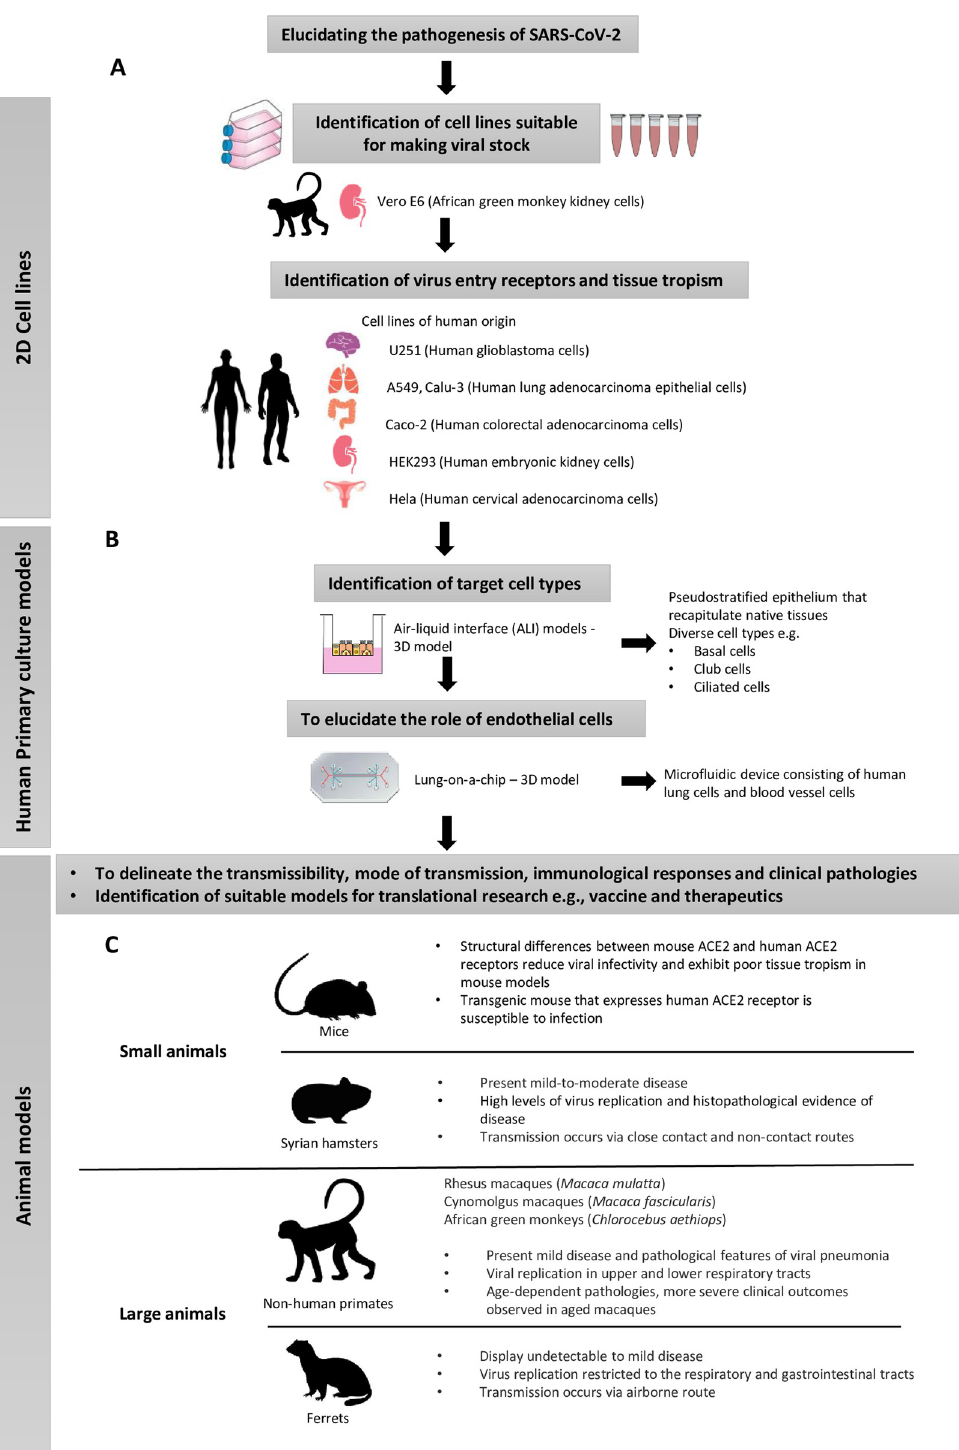
Fig 1. A flowchart illustrates the 2D cell lines, 3D models, and animal models for the understanding of the pathogenesis of SARS-CoV-2. (A) Most 2D models originated from both human and nonhuman origins more than half a century ago, thus may not be biological relevant. However, they are easily and readily available, hence form an important first-line model for research in a pandemic to identify potential pathways of infection, tissue tropism and to generate viral stocks for further research. (B) Human primary ALI (3D model) mimics conditions in the human airway,